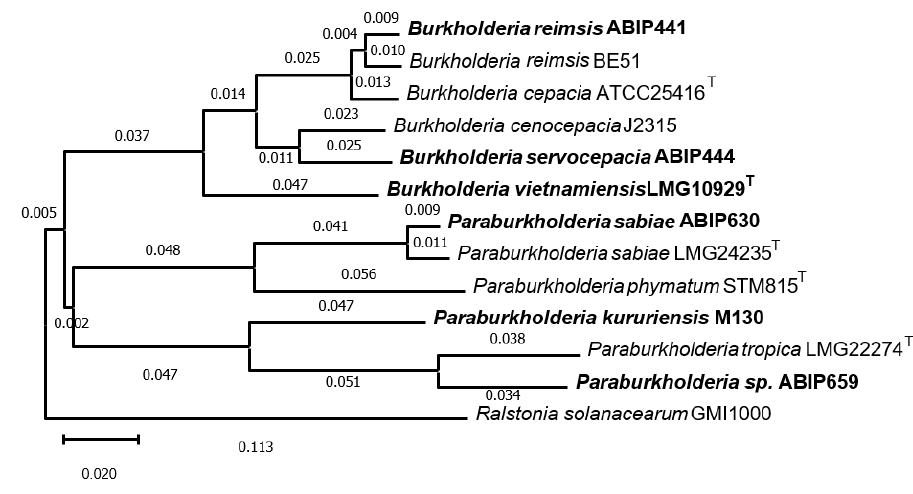
Figure 1 - Genome clustering of studied strains (in bold) with their closest species neighbors. The tree was constructed using the Genome clustering tool of the Microscope plateform (https://mage.genoscope.cns.fr/microscope/). Distances between whole genomes was computed using Mash (Ondov et al., 2016) and plotted using the rapid Neighbor-Joining method (Simonsen et al., 2008) . The displayed distances are correlated to average nucleotide identity (ANI) such as D ≈ 1 - ANI. Genbank genome accession numbers of strains under study are indicated in Table